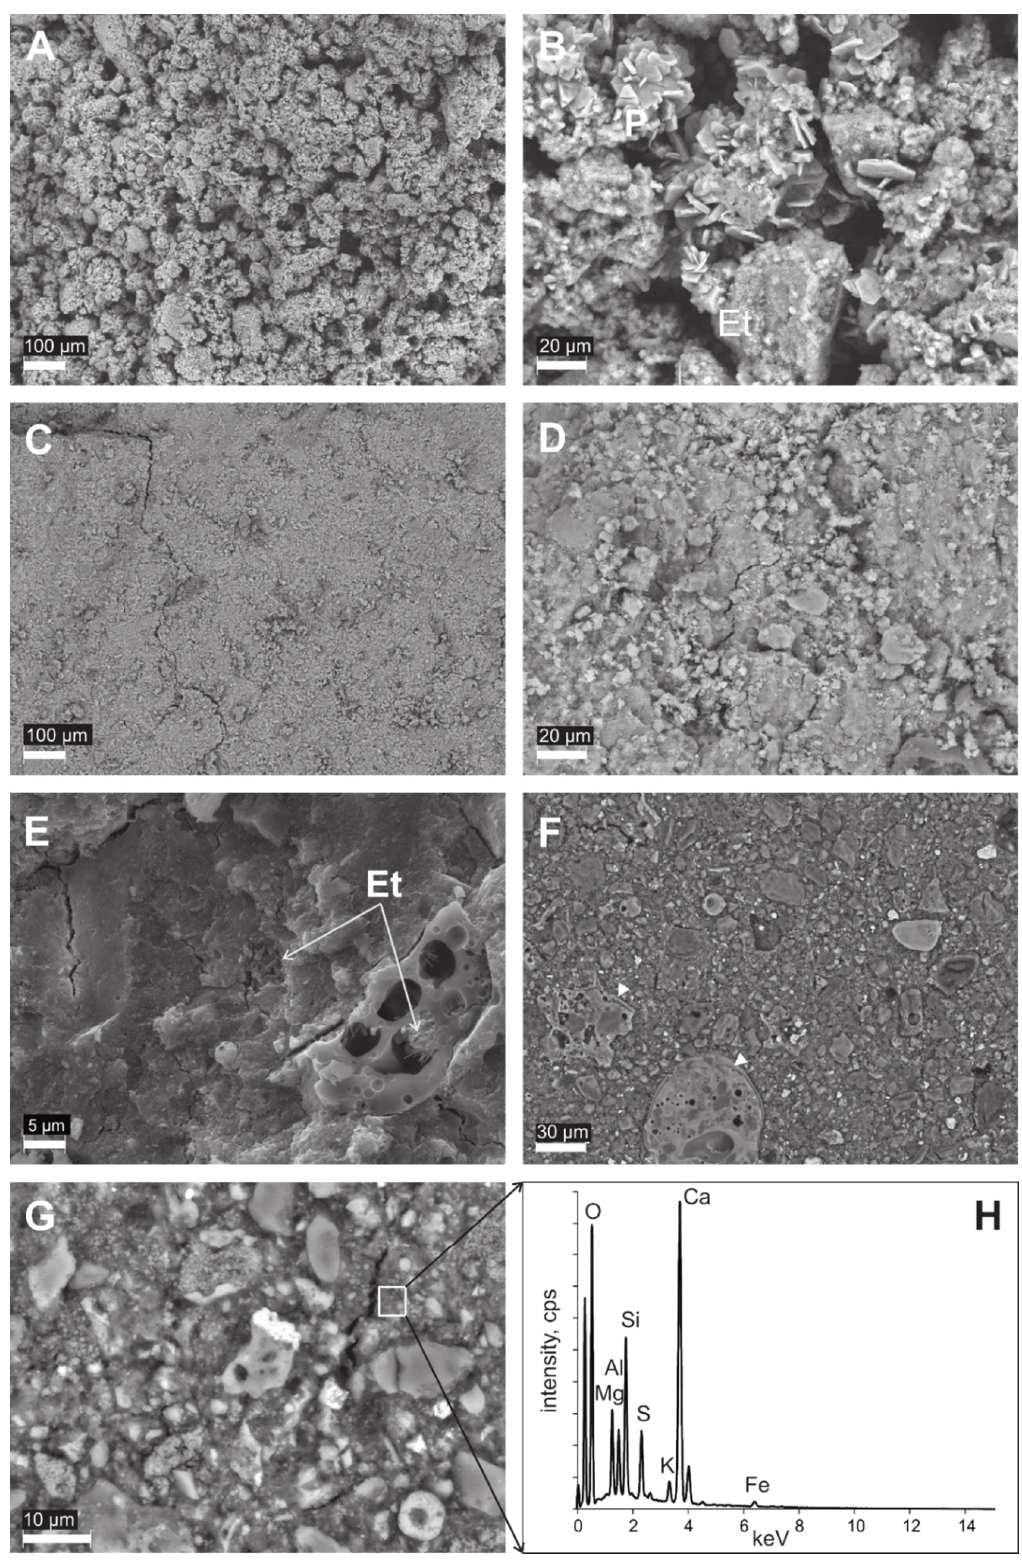
Figure 10. SEM backscattered electron images of pastes made with raw ash ( A , B ) and mechanically activated ash after 90 days of curing ( C – G ). Images A–D are broken surfaces. Images F and G are polished surfaces. Note a thin, few to 10 µm thick, alteration rims on glassy cenospheres ( F ). Energy dispersive spectrum ( H ) of the area in image G. P—portlandite, Et—ettringite.